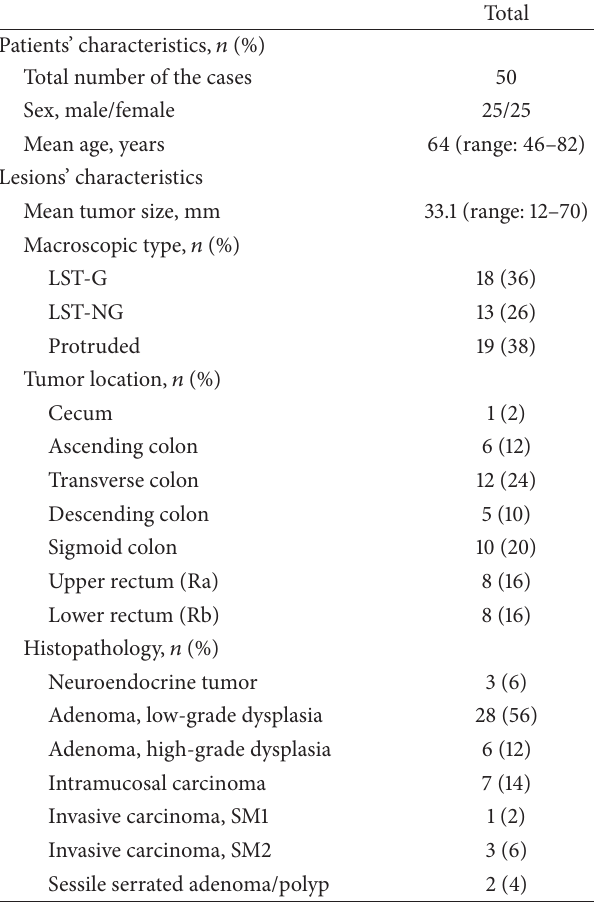
Table 1: Patient and tumor characteristics.